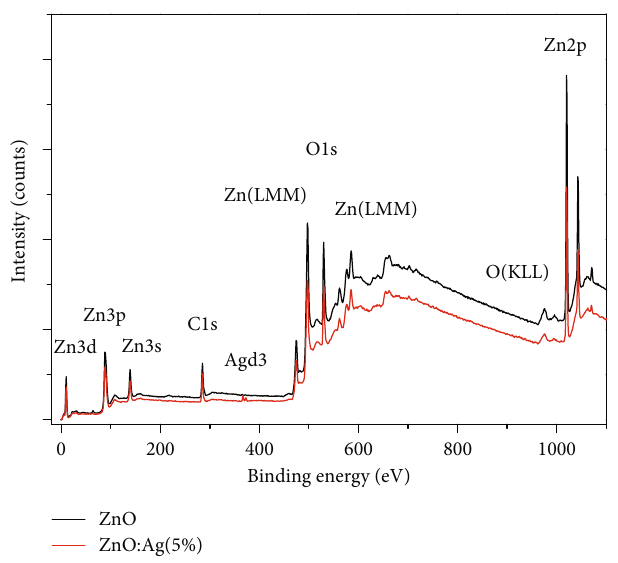
Figure 3: XPS spectrum for both ZnO and ZnO:Ag (5%) thin fi